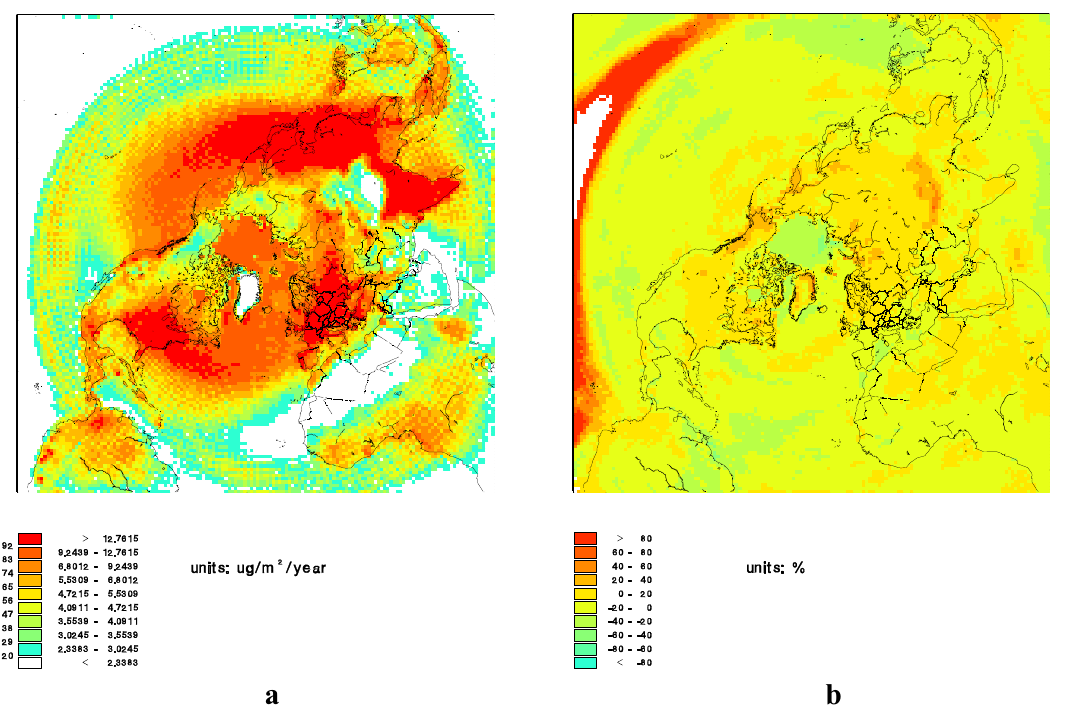
Figure 4. Average of the total annual mercury deposition for the 1990s ( a ) and change in deposition in percent from the 1990s to the 2090s ( b